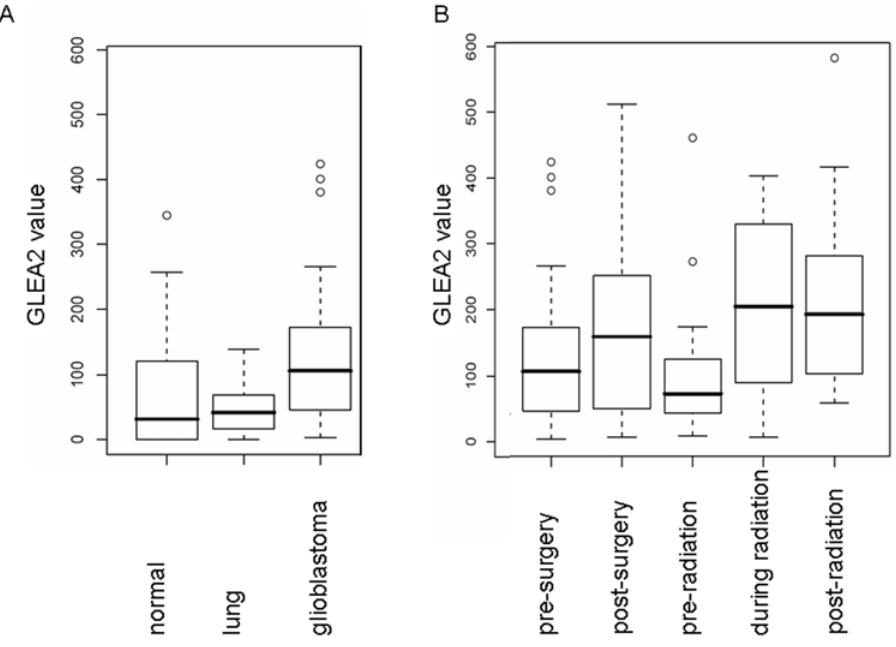
Figure 1. GLEA2 seroreactivity. (A) Comparison of GLEA2 seroreactivity between glioblastoma patients, healthy volunteers, and lung cancer patients as control groups. The differences between the controls and the glioblastoma patients group were statistically significant. The difference between the two control groups was not significant. (B) Comparison of GLEA2 seroreactivity between glioblastoma patients prior to surgery, after surgery, prior to radiation, during radiation and after radiation. The differences were significant between pre-radiation and during radiation. Black bars correspond to median values, the dazed lines to the 75% quantiles, circles represent outliers.